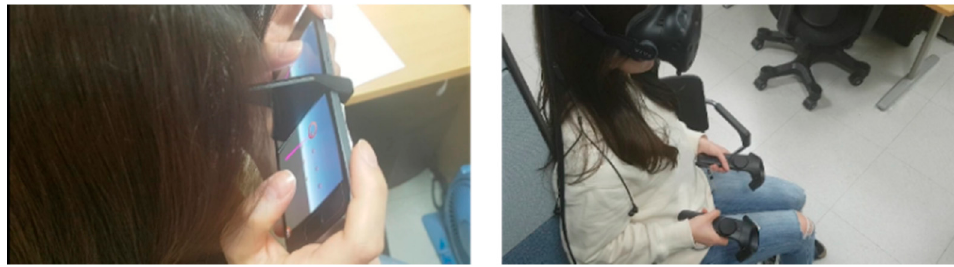
Figure 7. The experimental set-up: (1) for the BTF-T and BTF-R using a smartphone based Easy M-VR ( left ) and (2) CONT using the PC based VR with the HTC Vive HMD/controllers ( right ).